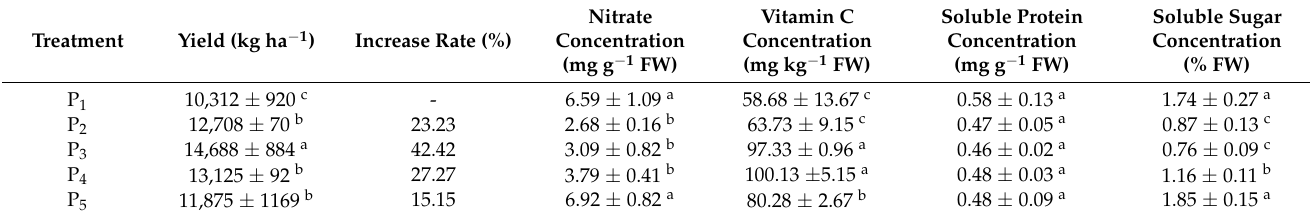
Table 3. Effect of different P application rates on yield and quality of